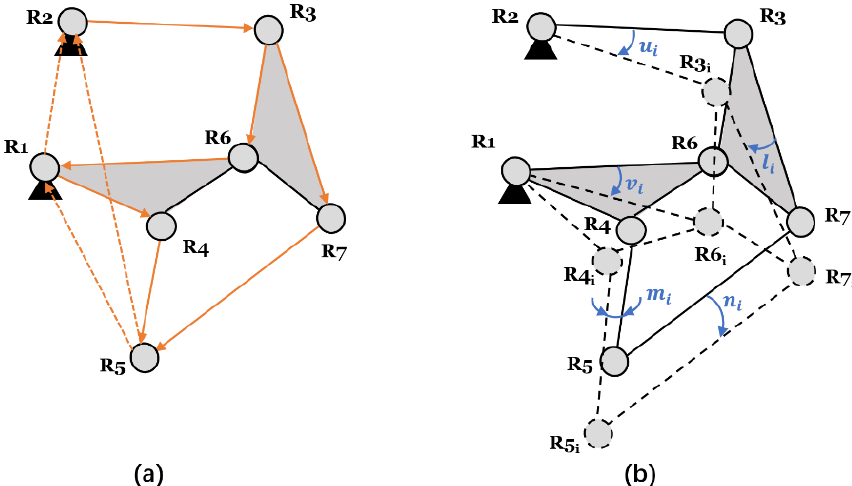
Figure 4. (a) The synthesis loops of the six-bar linkage and (b) the related linkage configurations with rotation u i .